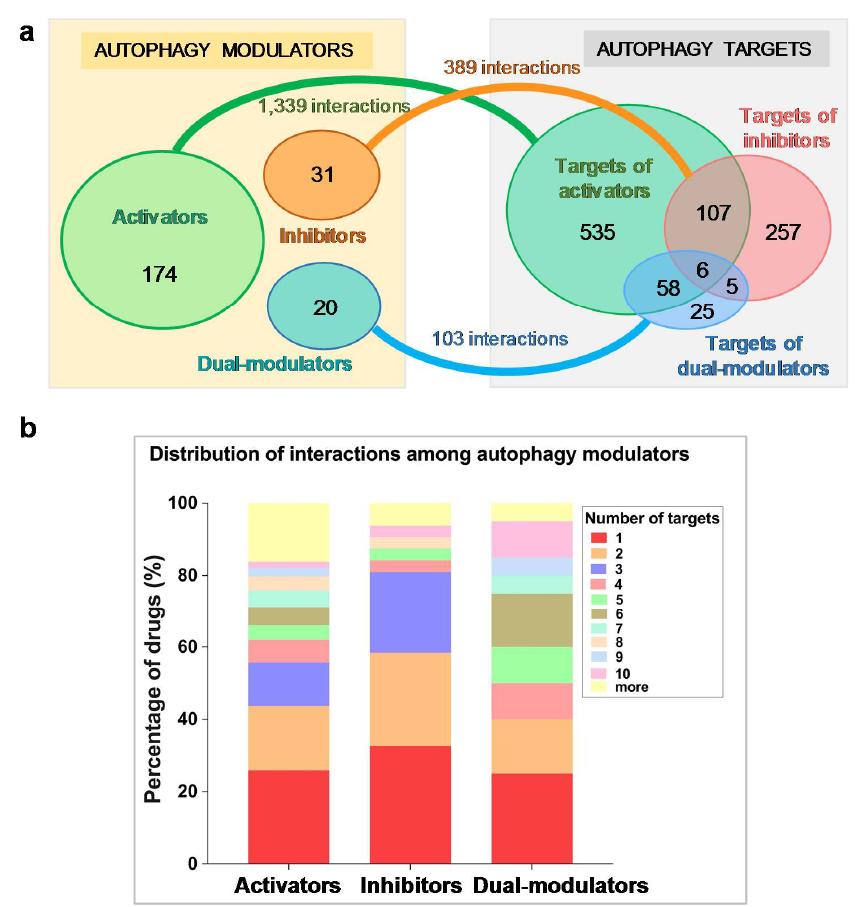
Figure 1. Space of autophagy modulators and their targets. ( a ) On the left we show three groups of autophagy modulators, and on the right the corresponding targets, which show considerable overlap. The number of targets in each subset are shown by the labels in the Venn diagrams on the right . The numbers on the linkers connecting the drugs to the targets indicate the number of targets associated with each category of autophagy modulators; ( b ) Distribution of the degrees (number of associated targets) for each category of autophagy modulators.